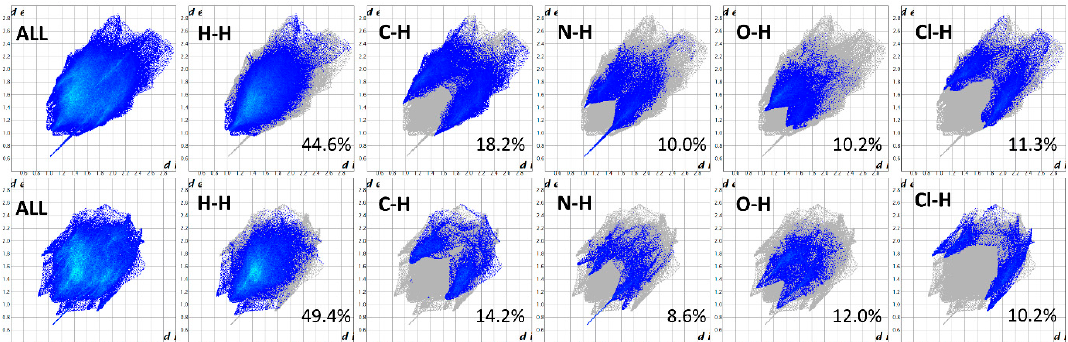
Figure 8. Two-dimensional Hirshfeld fingerprints for ITR–TER (top) and ITR–SUC (bottom) cocrystals.